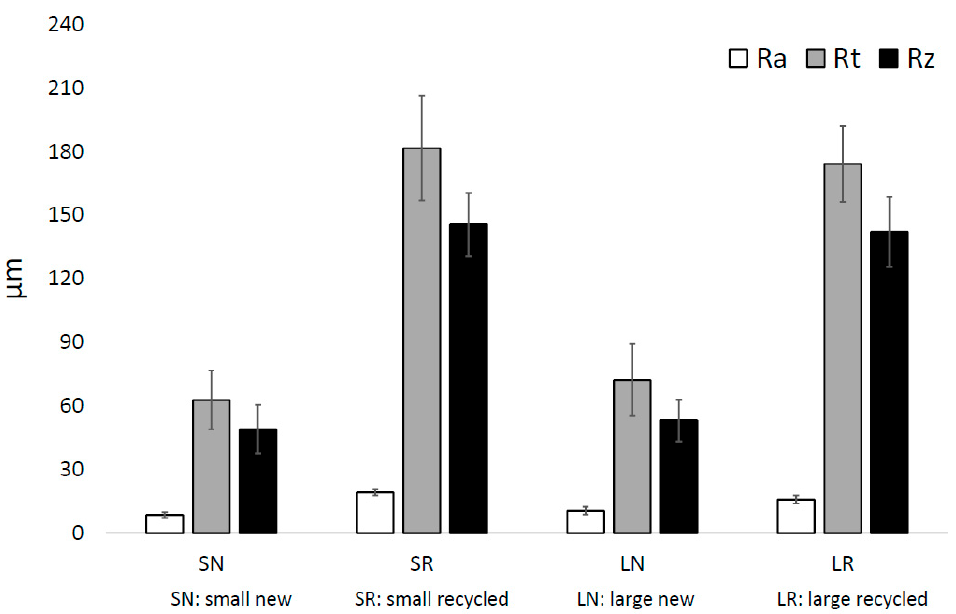
Figure 2. Mean and standard deviation of the arithmetical mean roughness (Ra), the total height of the roughness profile (Rt), and the mean roughness depth (Rz) of the LPBF Ti-6Al-4V specimens: small diameter and new powder (SN), small diameter and recycled powder (SR), large diameter and new powder (LN), and large diameter and recycled powder (LR).